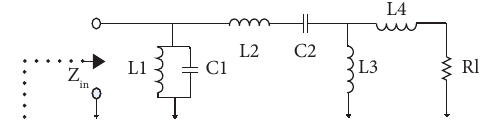
Figure 27: Adding matching circuit on the base of Figure 25.